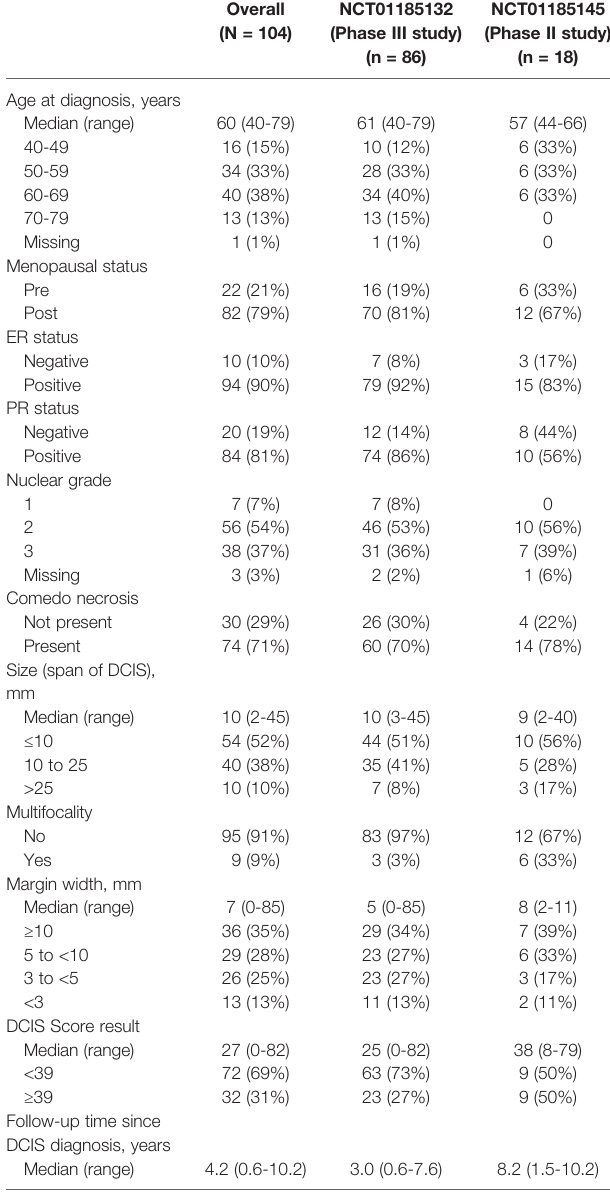
TABLE 1 | Patient characteristics, overall and by clinical